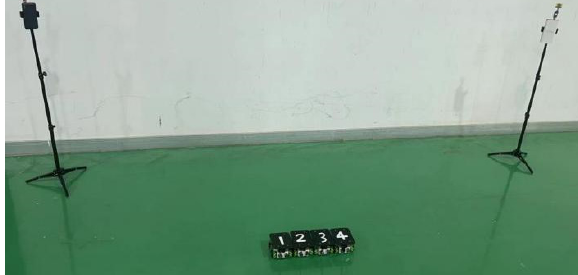
Figure 26. Initial configuration state of modular vehicles.